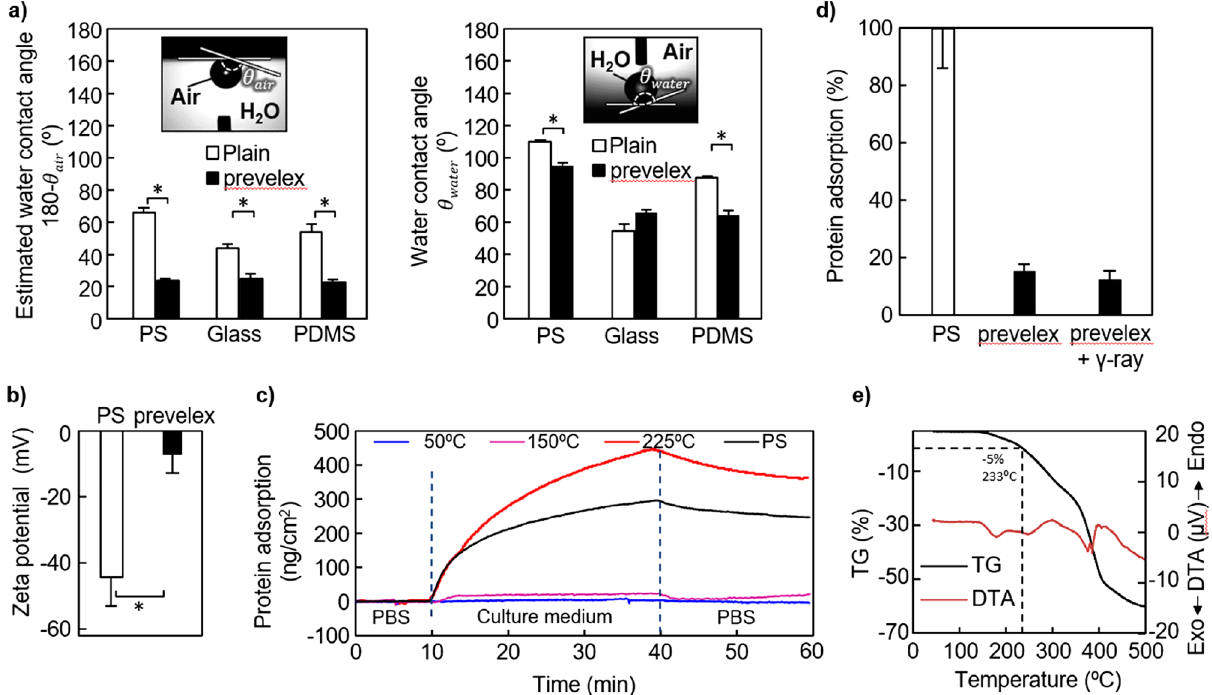
Figure 2. Characterizations of prevelex-coated surfaces. ( a ) Water contact angles with and without prevelex coating on PS, glass, and PDMS substrates under aqueous and dry conditions. The bubble contact angle θ air is measured with a 2.0 µL air bubble in PBS. The water contact angle θ water is measured with a 2.0 µL pure water droplet in air. θ air is converted to θ water by 180 − θ air . ( b ) Zeta potential of polystyrene substrates with and without prevelex coating. ( c ) Dependence of prebake temperature on protein adsorption. QCM sensor is treated with prevelex and heated at the indicated temperature for 1 h. QCM is used to quantify adsorption of molecules in Eagle’s basal medium supplemented with 10% FBS. ( d ) Protein adsorption after gamma irradiation. The values are presented relative to polystyrene (PS) substrate. ( e ) Thermogravimetric and differential thermal analysis (TG–DTA) of prevelex. Error bars in ( a ), ( b ), and ( d ) represent the standard error calculated from